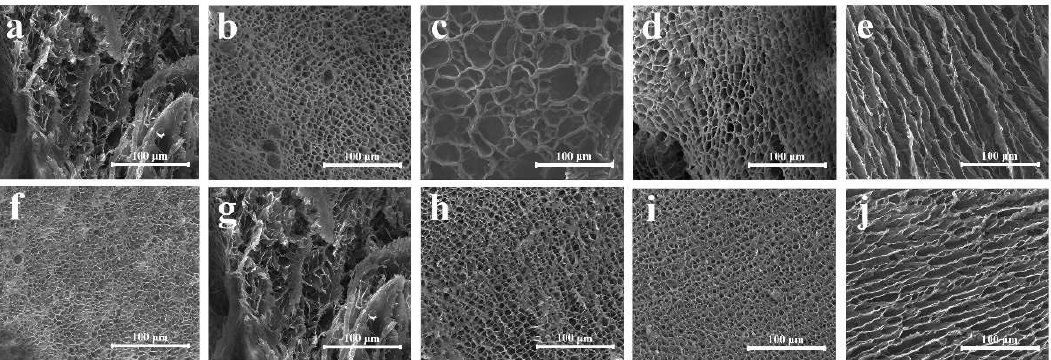
Figure 6. SEM images of gels formed in different solvents: ( a – e ) Acetone was the solvent and PGG solution/solvent ( v/v ) ratio changed from 1:1 to 1:5; ( f – j ) THF was the solvent and PGG solution/solvent ( v/v ) ratio changed from 1:1 to 1:5.